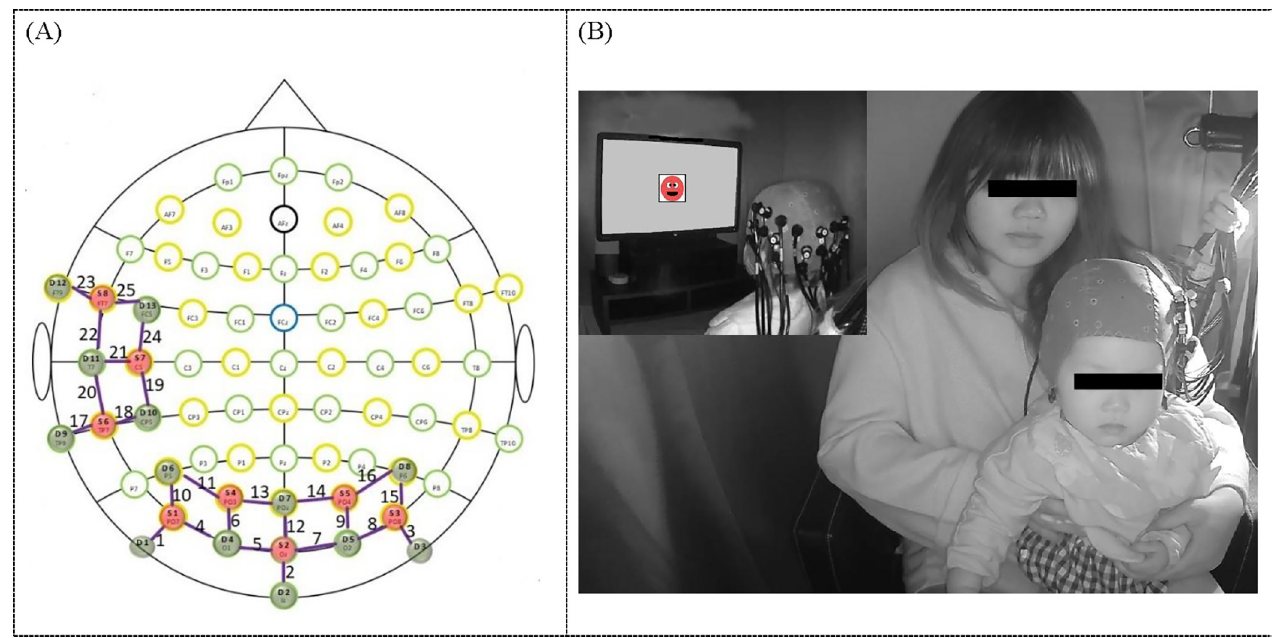
Fig 2. (A). Channel placement over occipital and temporal areas. Red circles indicate sources and green circles indicate detectors. (B). Picture of a 12-month- old sitting in his mother’s lap inside the blackout-curtain-surrounded area during the experiment. The panel inserted in the upper left corner shows the back view of the infant with cap placed upon the head, and the schematic depicts the screen from the infant’s point of view.